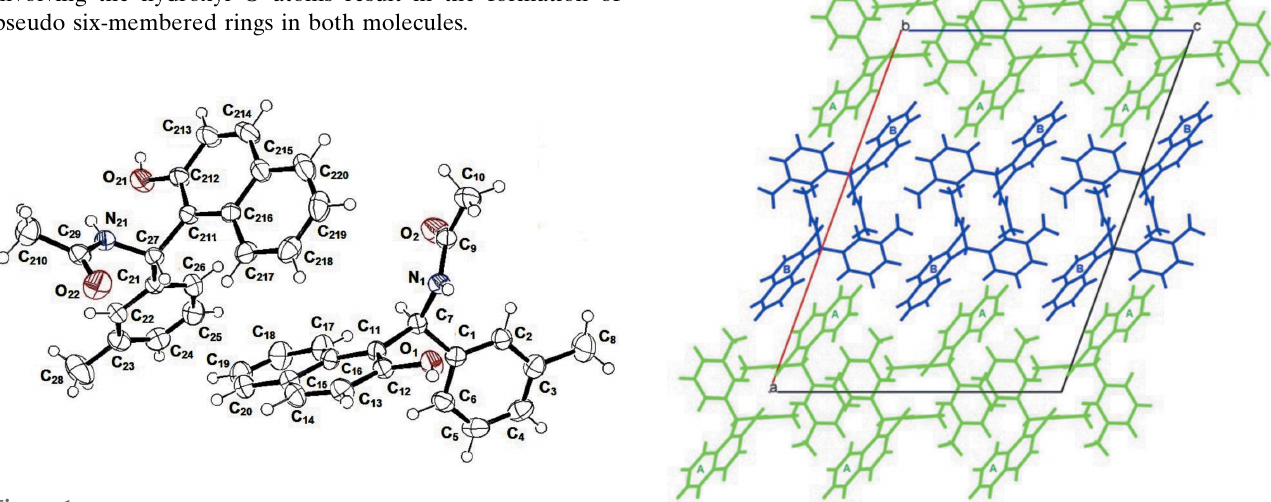
Figure 1 The molecular structure of the title compound, with atom labelling and displacement ellipsoids drawn at the 50% probability level.